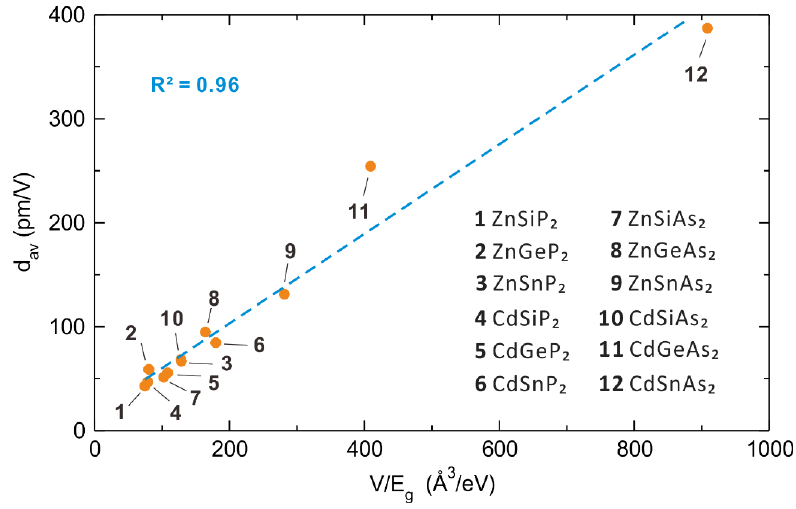
Figure 20. The relationship between SHG ( d av ) and V / E g of the 12 ABC 2 ( A = Zn, Cd; B = Si, Ge; C = P, As) chalcopyrites.